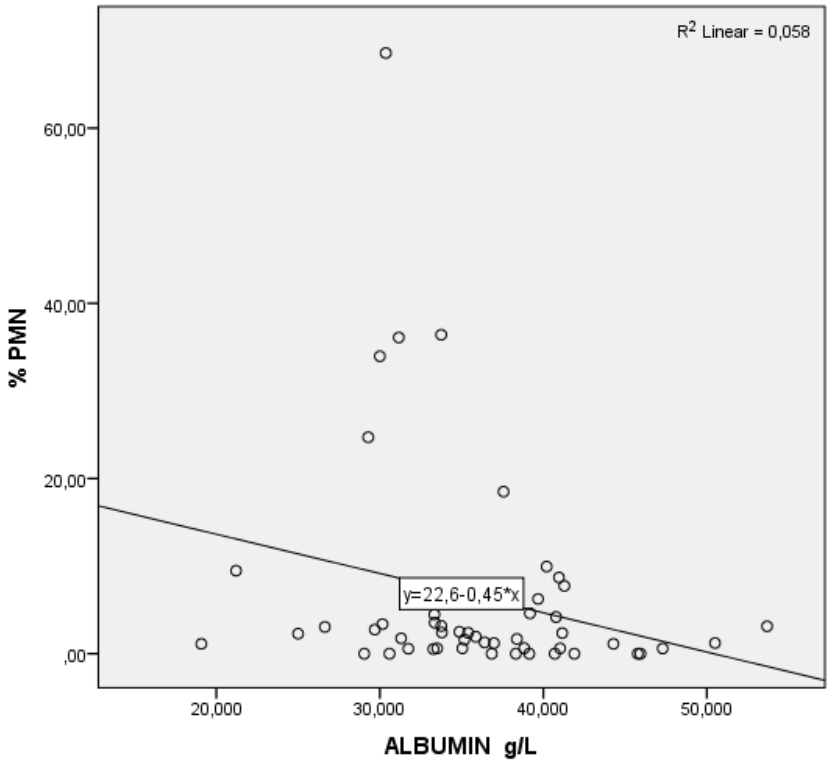
Animals 2022 , 12 , x FOR PEER REVIEW Figure 2. Partial regression graphic of albumin (independent variable) and its relation with the percentage of polymorphonuclear neutrophils (%PMN, dependent variable).